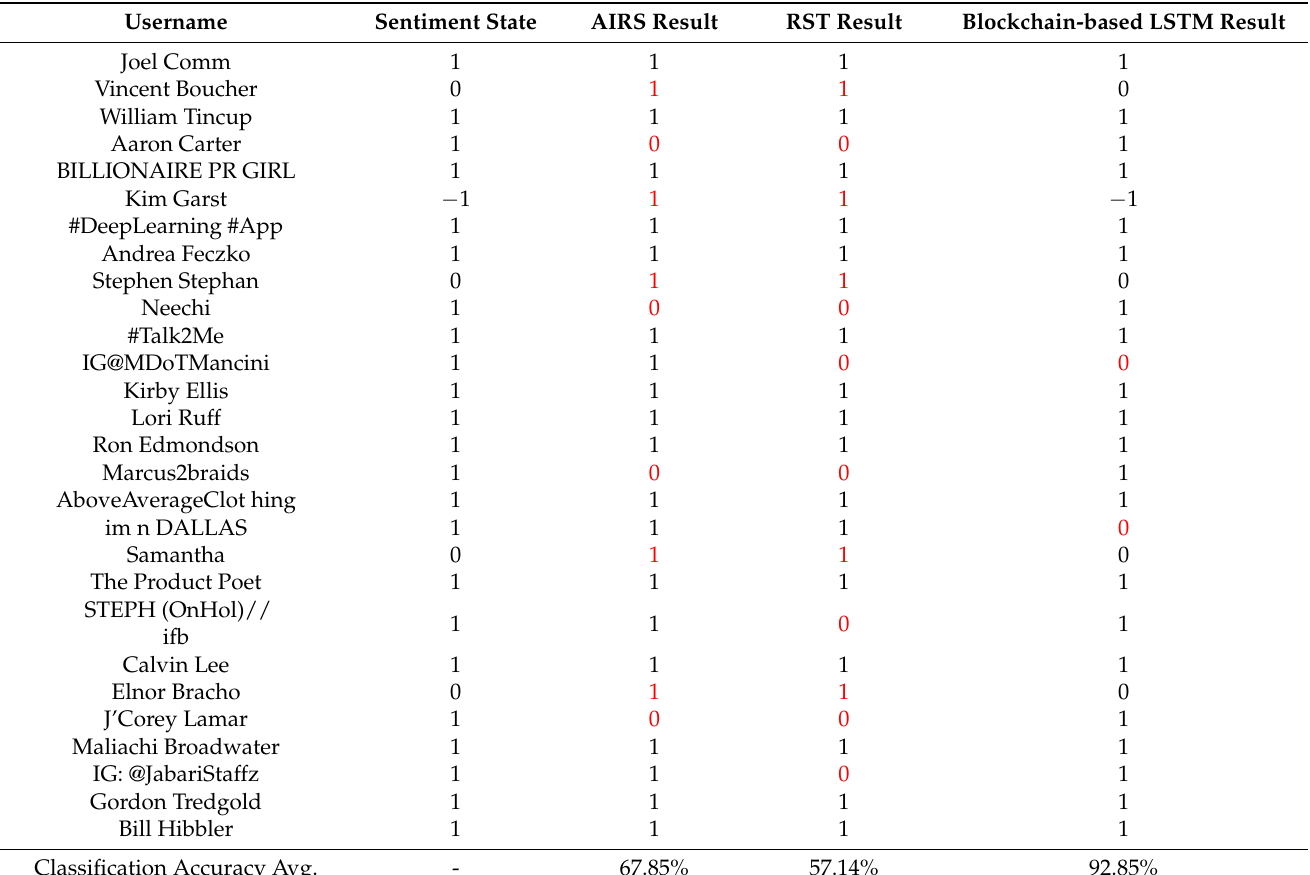
Table 8. Benchmark of data set evaluation